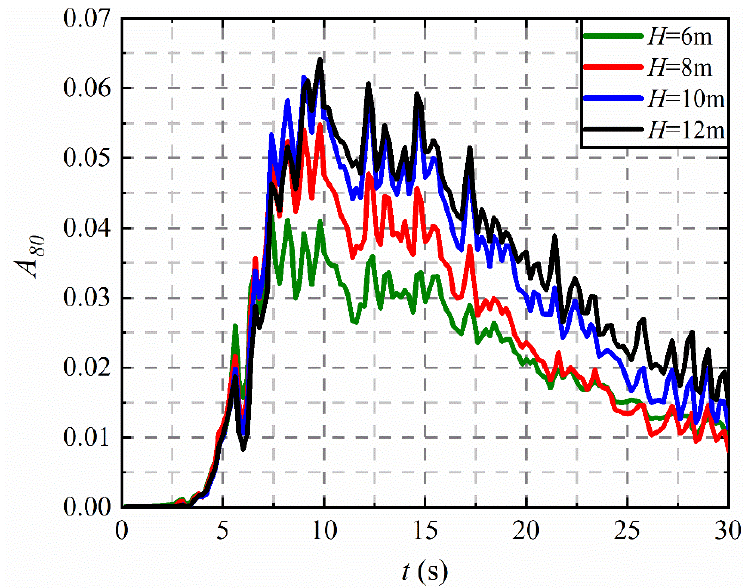
Figure 8. Comparison of mean time history of ground liquefaction range under different embed- ment depths.